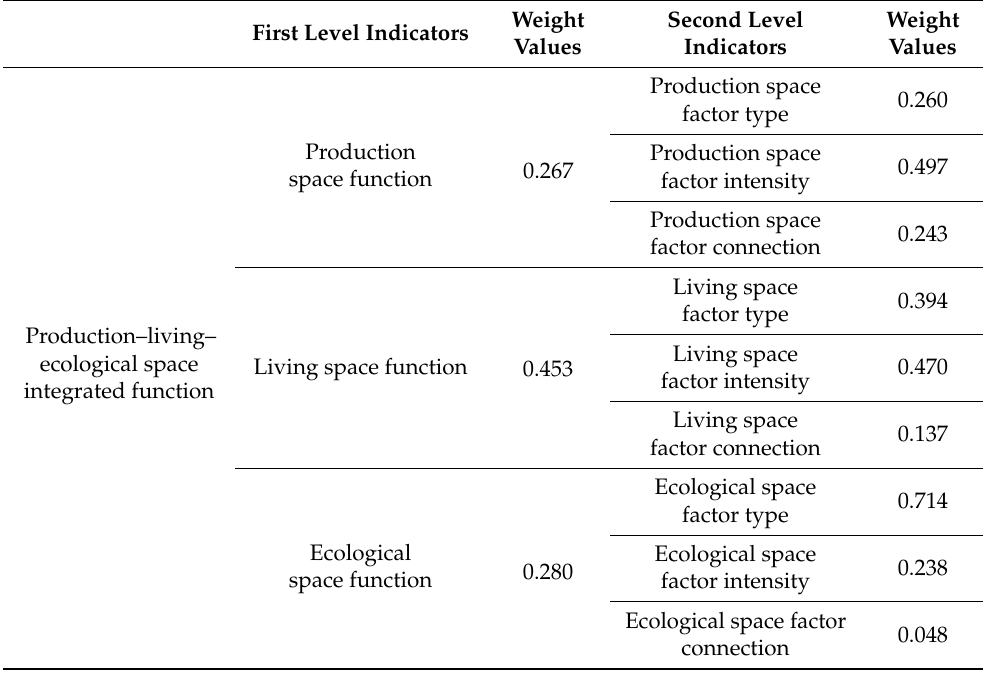
Table 6. Weight values of production–living–ecological space function evaluation